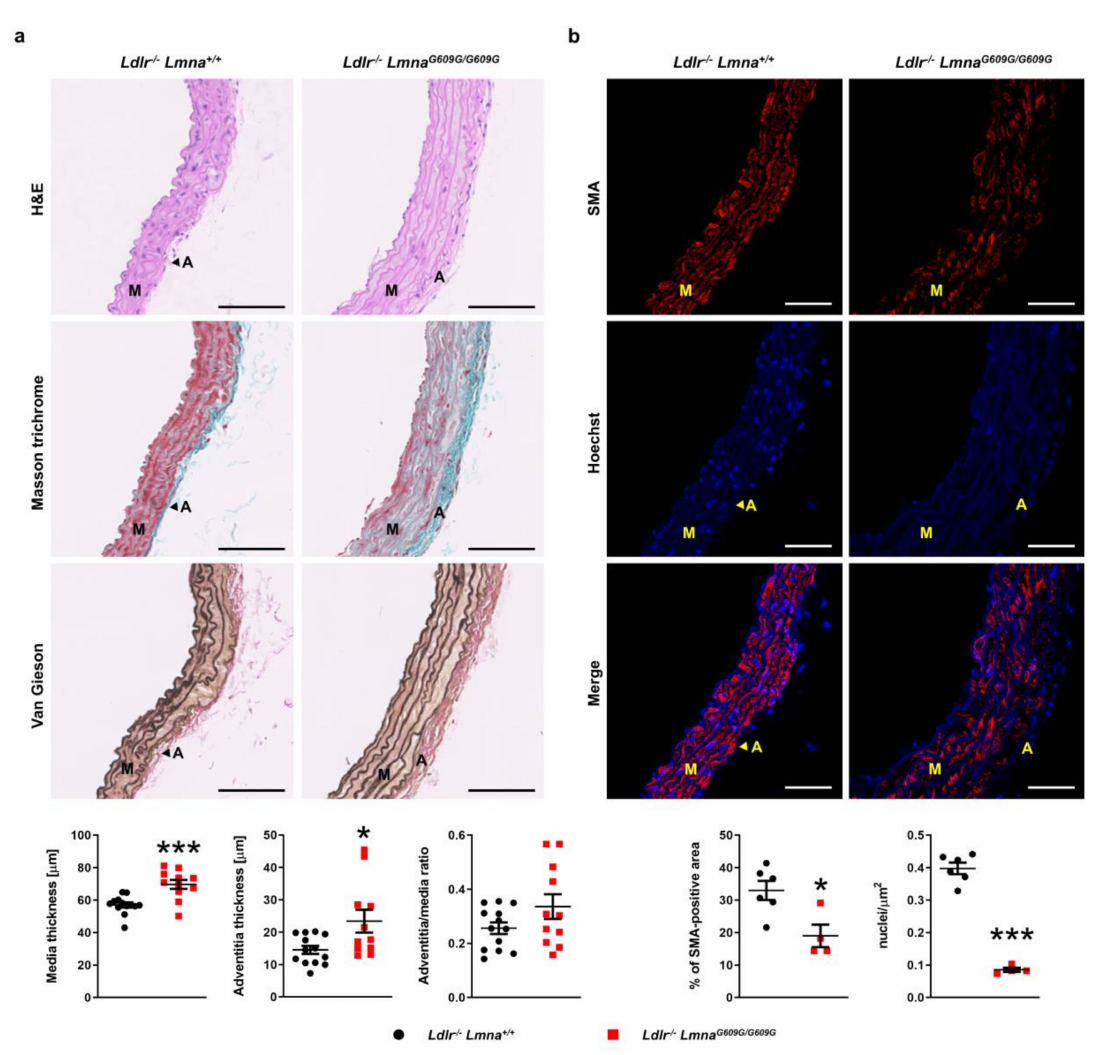
Figure A5. Pathological changes in the aortic wall of fat-fed female Ldlr − / − Lmna G609G / G609G mice. Female mice were fed a high-fat diet from eight weeks of age and sacrificed at 16 weeks of age. ( a ) Representative images of aortic arch sections stained with hematoxylin–eosin (H&E), Masson trichrome, and Van Gieson stain. Scale bar, 100 µ m. Graphs show medial and adventitial thickness and the adventitia-to-media ratio in Ldlr − / − Lmna +/+ mice ( n = 13) and Ldlr − / − Lmna G609G / G609G mice ( n = 11). ( b ) Representative fluorescence images of aortic arch sections stained with an anti- α -smooth muscle actin (SMA) antibody (red) and Hoechst 33342 nuclear dye (blue). Scale bar, 50 µ m. Graphs show the percentage of SMA-positive area and nuclei count / area in the media of Ldlr − / − Lmna +/+ mice ( n = 6) and Ldlr − / − Lmna G609G / G609G mice ( n = 4). Data are presented as mean ± SEM. Each point represents the mean for three aortic arch sections per mouse. Statistical analysis was performed by two-tailed t -test with Welch´s correction in ( a ) and by two-tailed t -test in ( b ). *, p < 0.05; ***, p < 0.001. M, media; A,